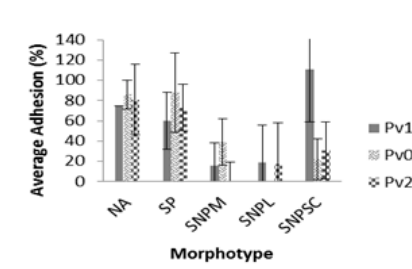
Figure 3. Average percent of adhered fungi in adhesion assays. ( A ) Average total percentage of adhered P. variotii strains (Pv19, Pv06, and Pv23) after treatment with A. striata (As) and reverse osmosis water (RO water) in adhesion assays that were repeated on three separate days with three replicates per day; ( B ) Average total percentage of the total adhered fungi per morphotypes (non-aberrated (NA), SP, SNPM, SNPL, and SNPSC) per P. variotii strain. * Indicates p -value < 0.001.